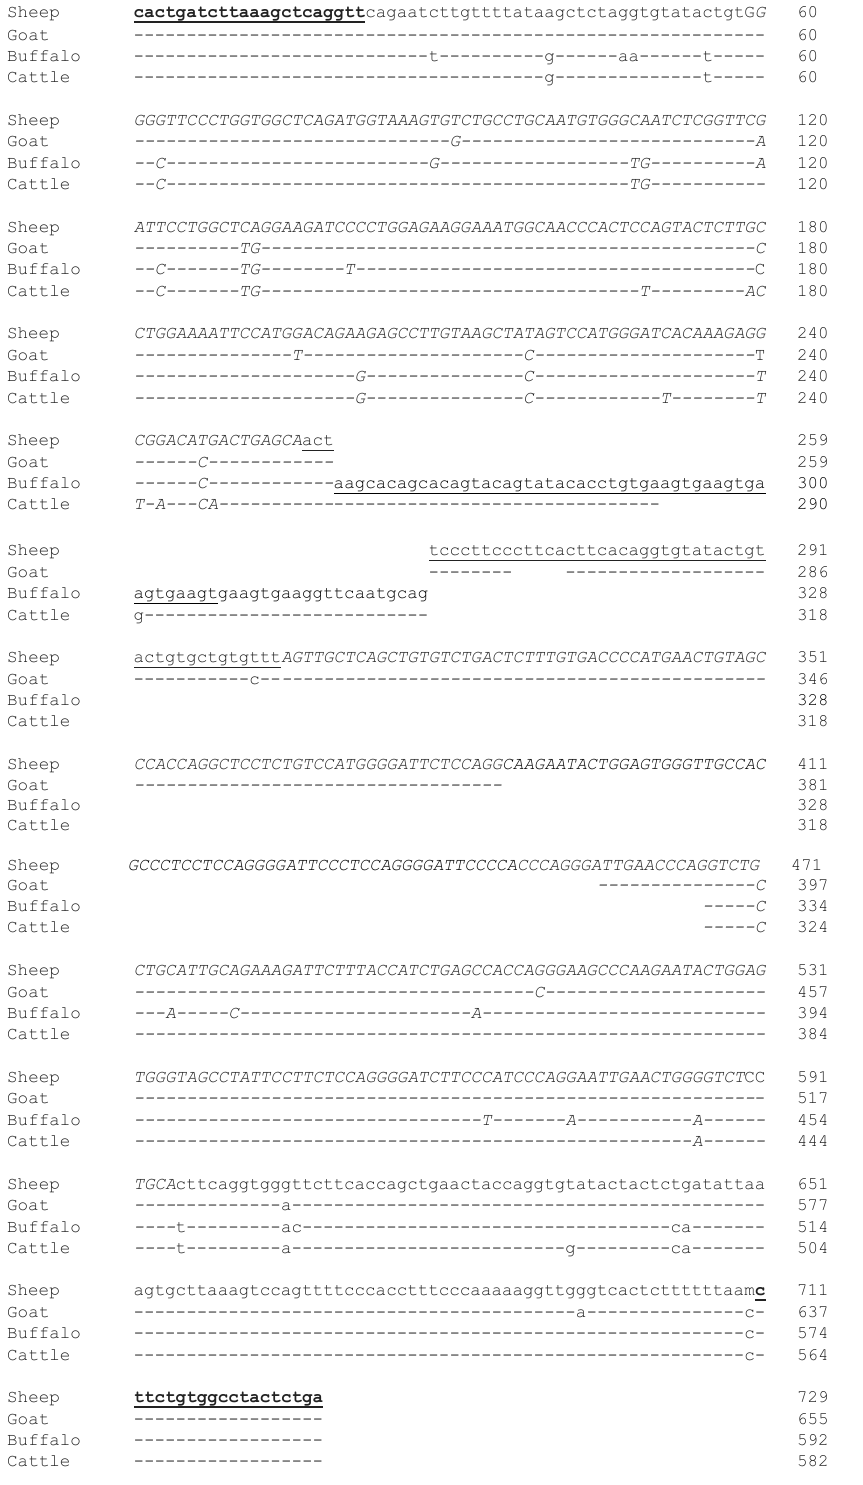
Figure 1. Homology between the nucleotide (nt) sequences of the 5’ flanking region of sheep (upper line), goat, buffalo and cattle α -lactalbumin (LALBA) gene. Dashes represent nt identical to those in upper lines. Primers for the simultaneous identification of DNA from four species of ruminants are in shaded bold letters. Artiodactyla retroposons sequences are in uppercase and italic letters and the 49 bp invertion is